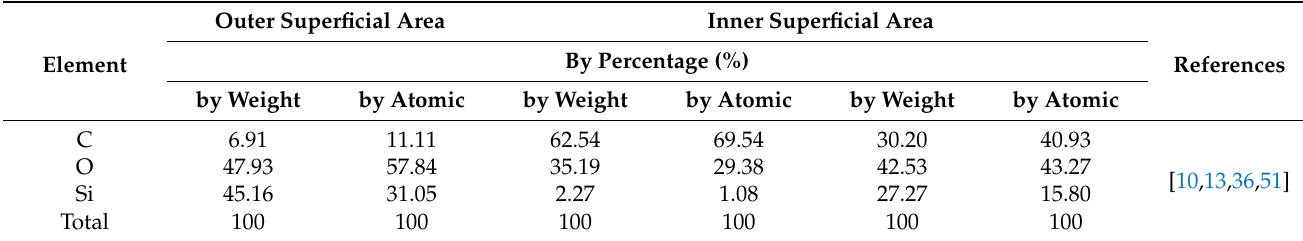
Table 2. Microanalysis of the RiH.